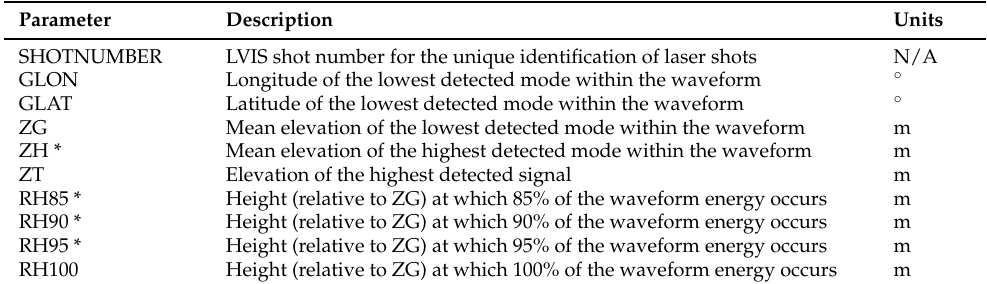
Figure 2. Locations and elevations of the points of the highest detected returns in three Laser Vegetation Imaging Sensor (LVIS) surveys over Costa Rica. From left to right: 1998 survey (2 tracks with 2,786,714 points), 2005 survey (5 tracks with 9,280,657 points), and 2019 survey (14 tracks with 5,195,224 points). Table 2. List of parameters from the Laser Vegetation Imaging Sensor (LVIS) Classic L1B Geolocated Waveforms and LVIS Classic L2 Geolocated Surface Elevation and Canopy Height Product used in the